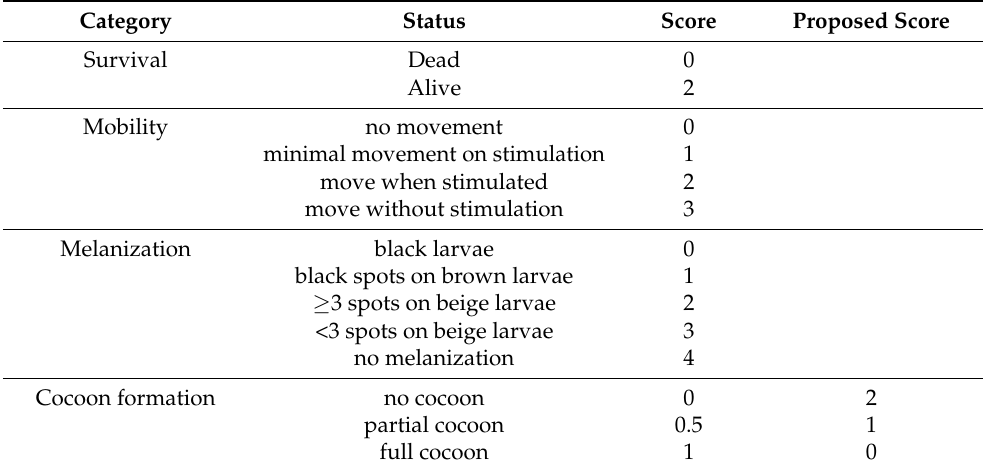
Table 1. The G. mellonella Health Index Scoring System [97] * and a new score for the “cocoon formation” category proposed. Category Status Score Proposed Score Survival Dead 0 Alive 2 Mobility no movement 0 minimal movement on stimulation 1 move when stimulated 2 move without stimulation 3 Melanization black larvae 0 black spots on brown larvae 1 ≥ 3 spots on beige larvae 2 <3 spots on beige larvae 3 no melanization 4 Cocoon formation no cocoon